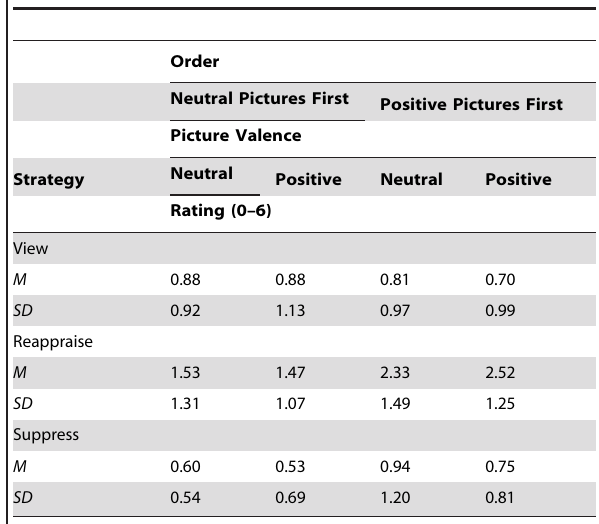
Table 2. Mean Negative Affect Ratings by Strategy (Reappraise, Suppress, or View), Picture Valence (Neutral or Positive), and Order (Neutral or Positive Pictures first).